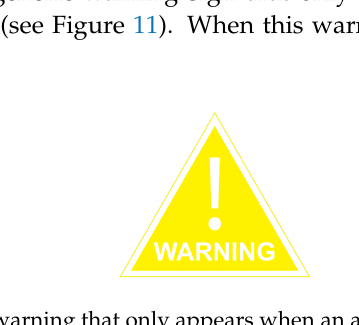
Figure 11. A generic warning that only appears when an accident is imminent to